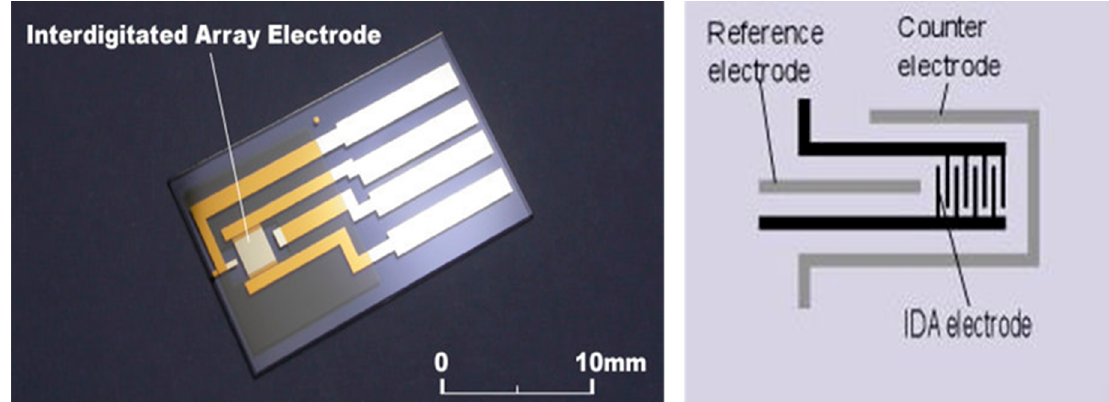
Figure 1. Picture ( left ) and diagram ( right ) of an Interdigitated Array Electrode (IDAE).